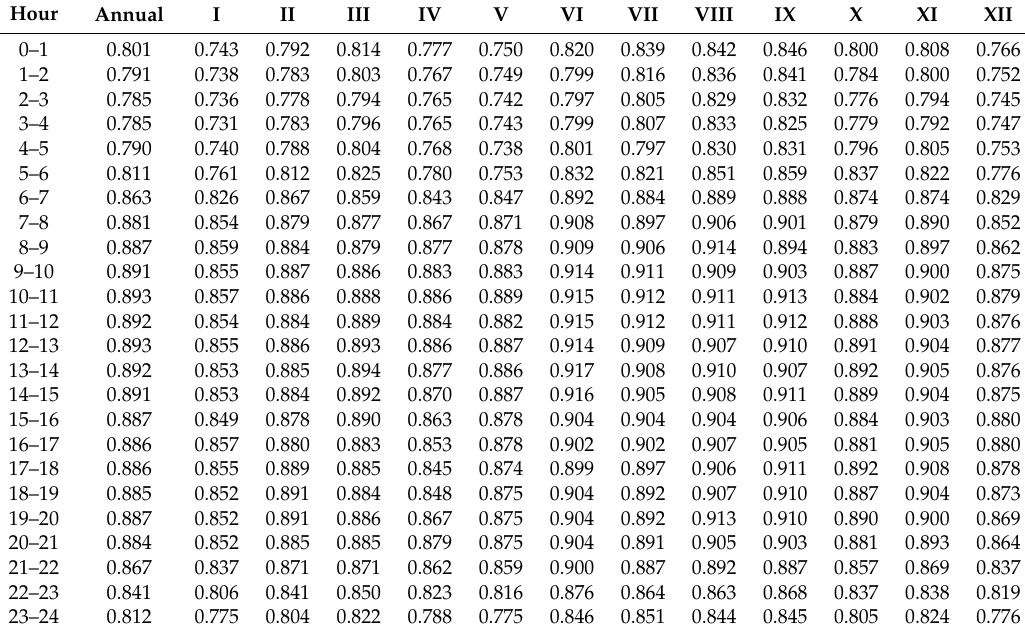
Table 2. Correlation coefficient for JWCD in 2018.